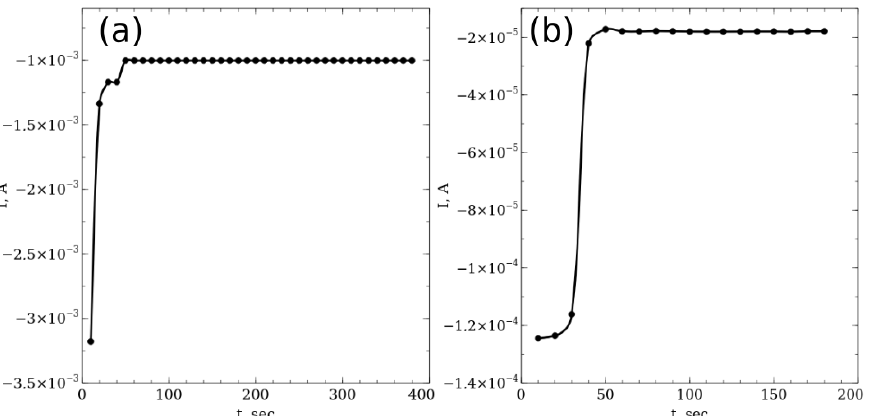
Figure 1. Chronoamperometric curves for the process of silver deposition (( a ) deposition on the flat glass/ITO/Au substrate (rhodanic electrolyte, U = − 0.27 V), ( b ) deposition into the opal matrix on glass/ITO (rhodanic electrolyte)).